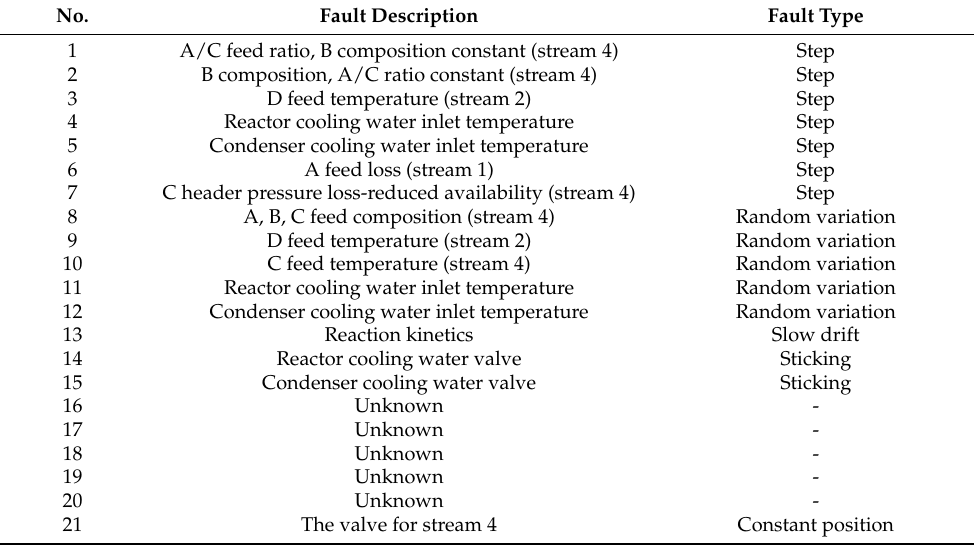
Table 2. The process faults in the Tennessee Eastman